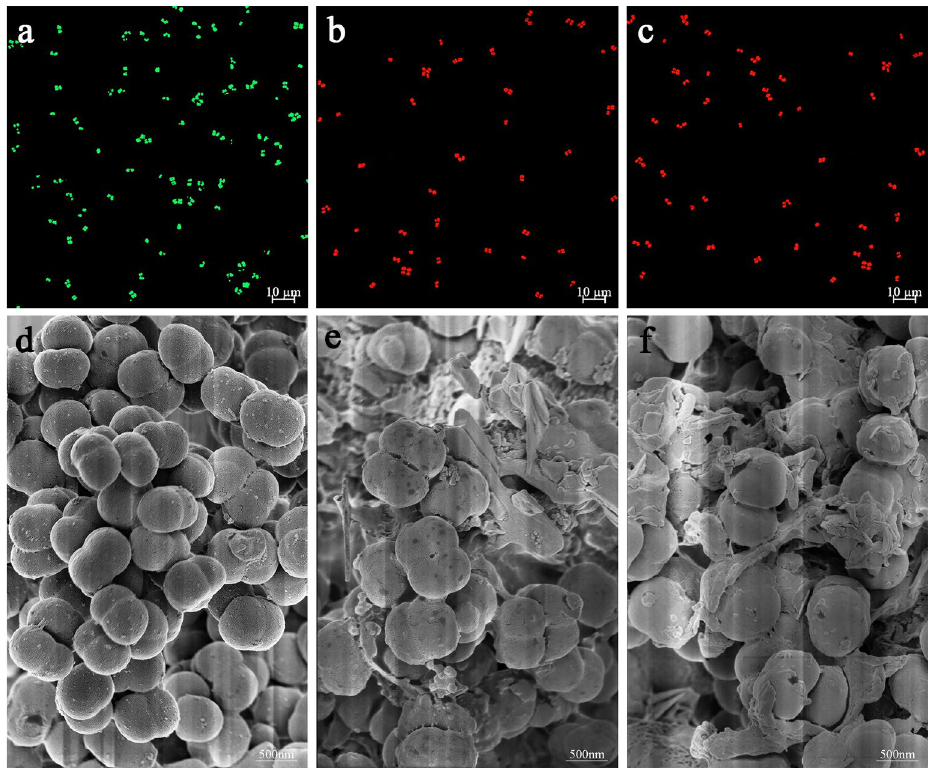
Figure 2. The effects of PCA on the cell membrane integrity of M. luteus BNCC 102589 by CLSM. M. luteus cells were treated with PCA at the ( a ) 0 × MIC, ( b ) MIC, and ( c ) 2 × MIC, respectively. The scanning electron micrographs of M. luteus BNCC 102589 under different treatments. M. luteus were treated with PCA at the ( d ) 0 × MIC, ( e ) MIC, and ( f ) 2 × MIC,